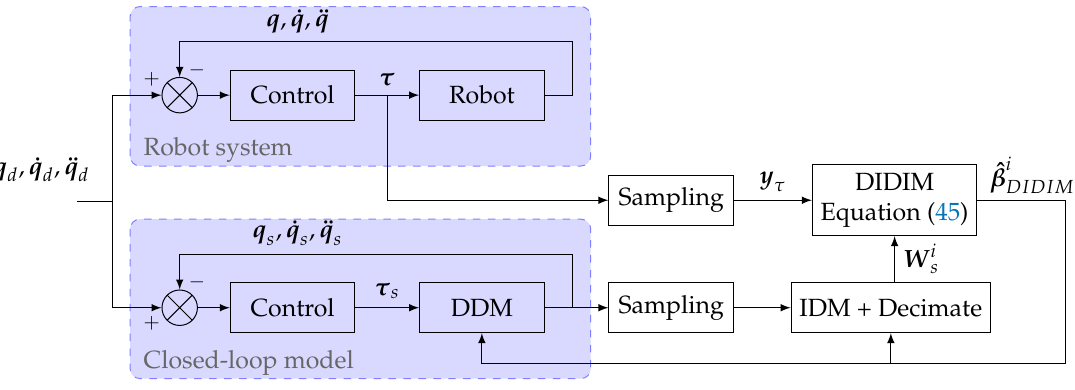
Figure 4. Block diagram of the DIDIM identification